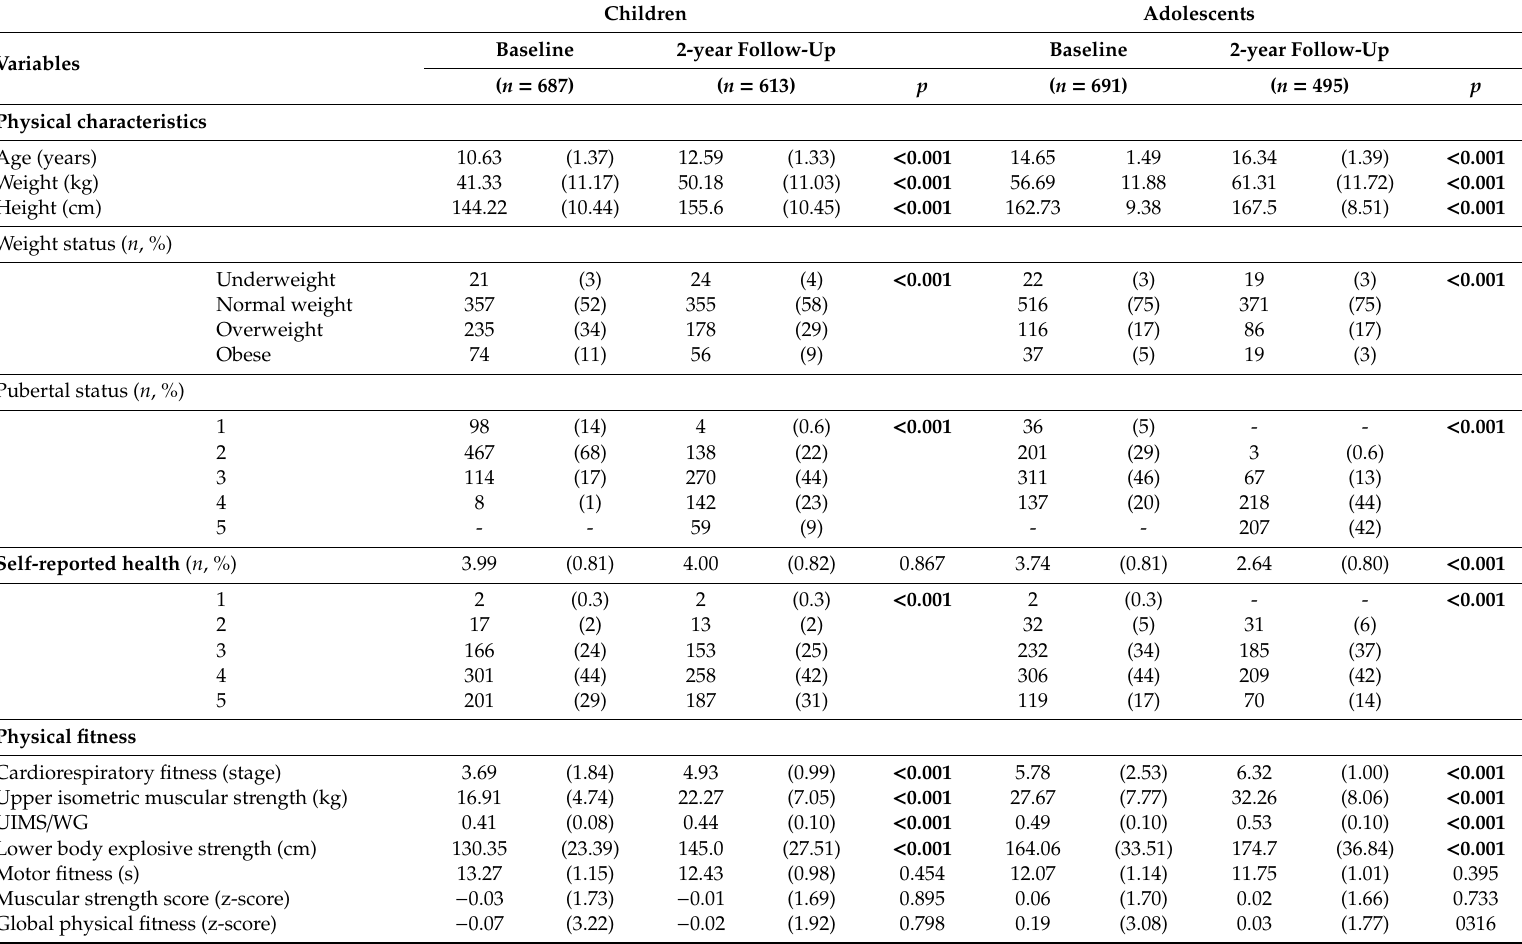
Table 1. Baseline and 2-year follow-up descriptive characteristics of the sample by age